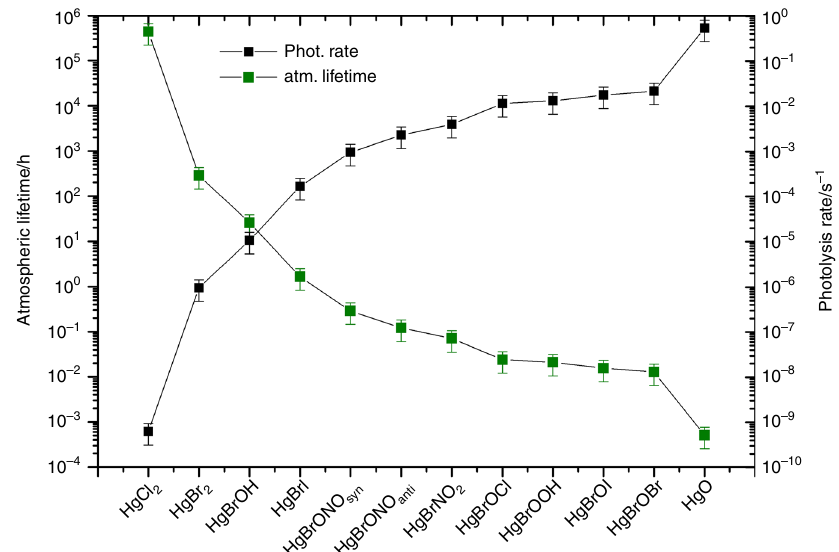
Fig. 4 Annually- and globally-averaged photolysis rate (s − 1 ) and lifetime (h) of Hg(II) compounds in the troposphere. Error bars correspond to one standard deviation